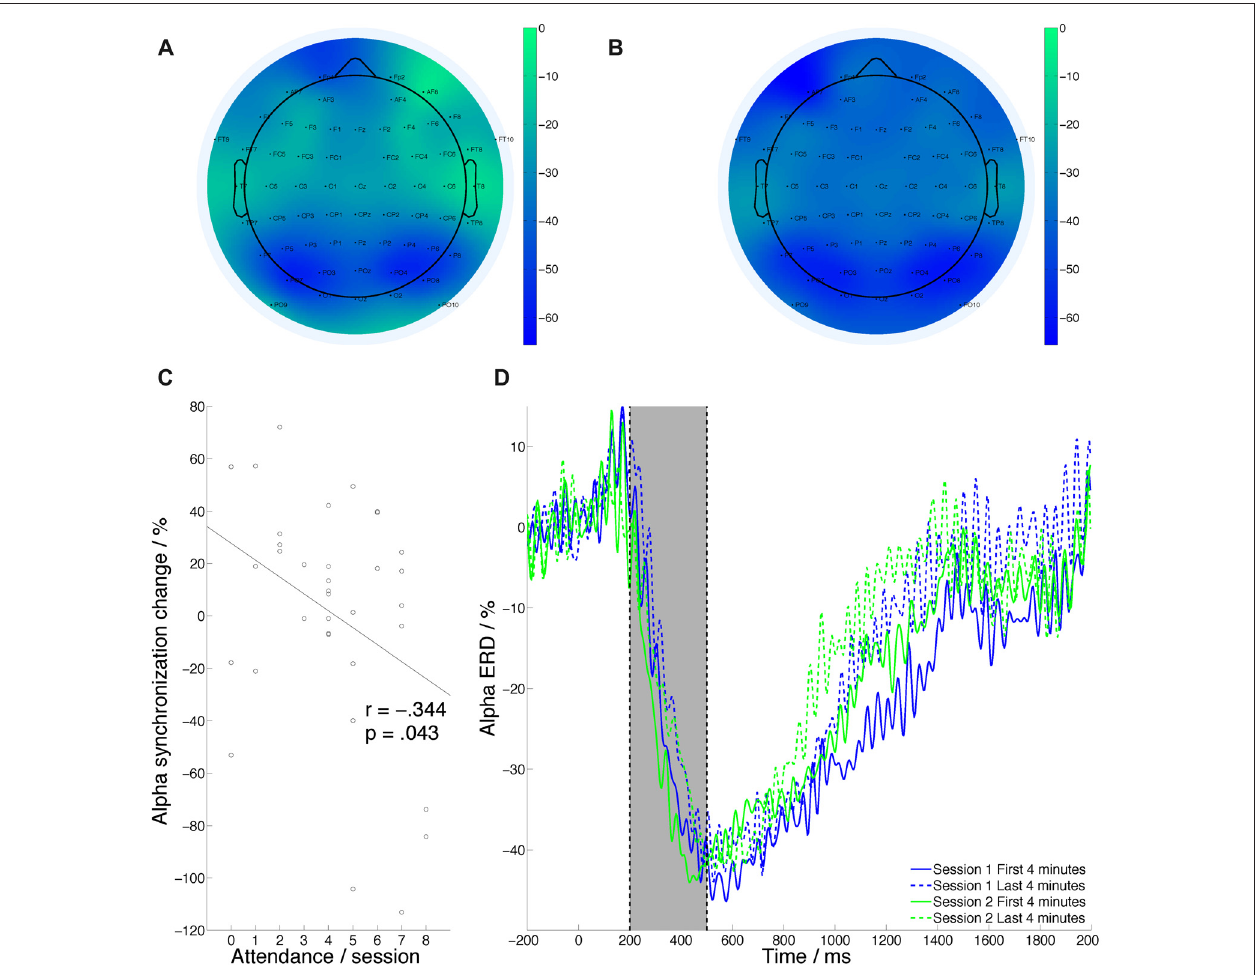
FIGURE 5 | Grand average event related desynchronization (ERD) topographic plot during PVT performance. (A) Before intervention. (B) After intervention. (C) ERD change across task and session is significantly correlated with MBT attendance. (D) Grand average